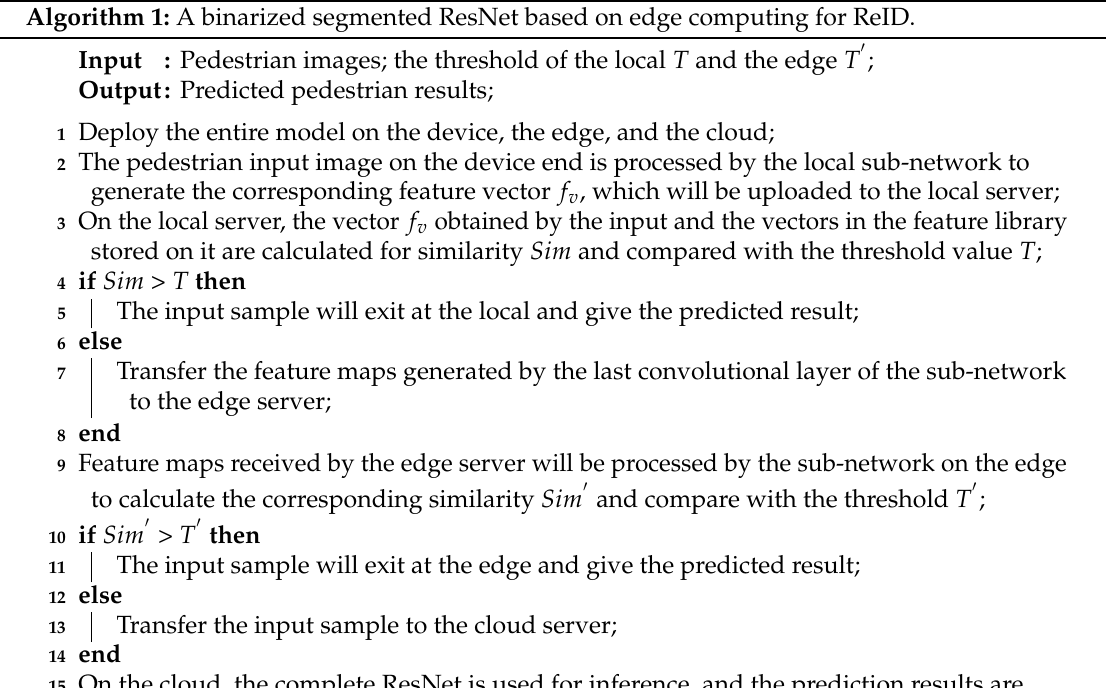
Algorithm 1: A binarized segmented ResNet based on edge computing for